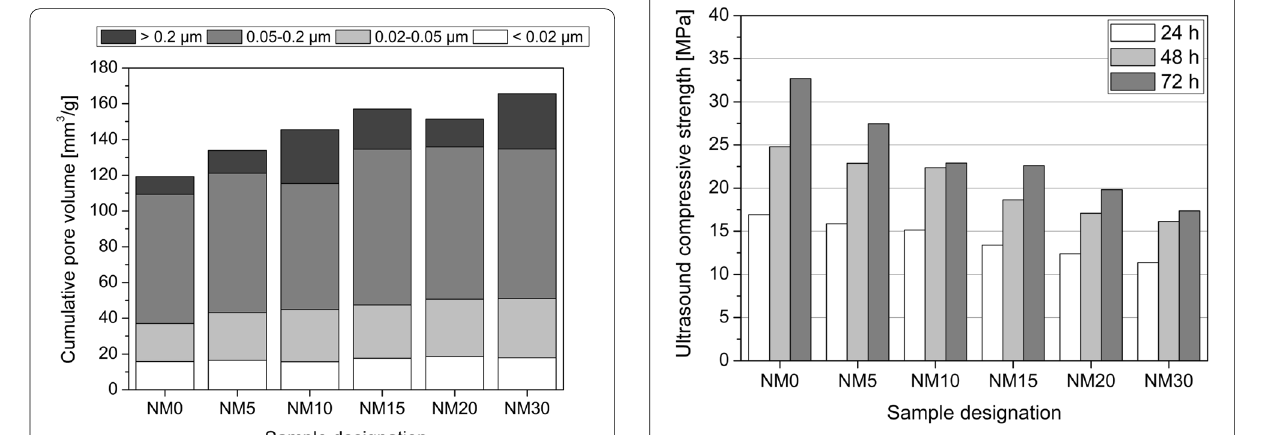
Fig. 5 Compressive strength of cement pastes after 24 h, 48 h and 72 h determined by